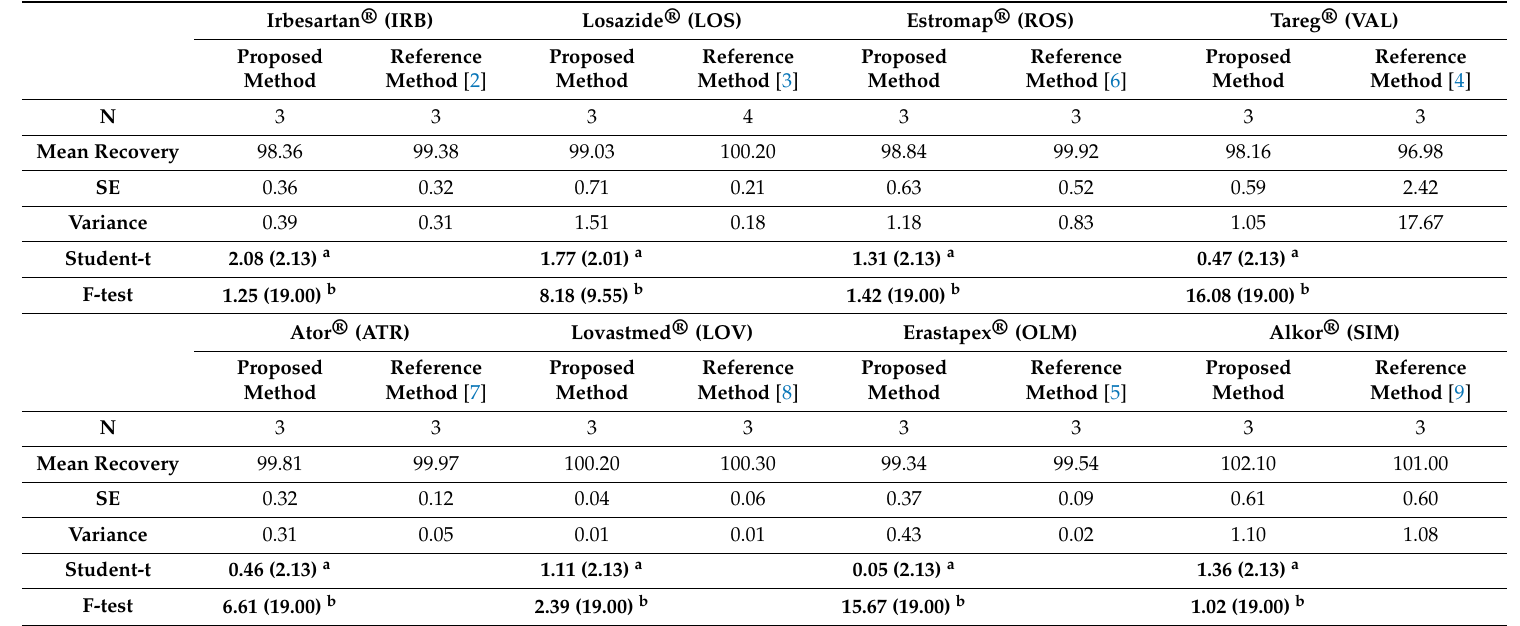
a and b are the theoretical student t-values and F-ratios at p =